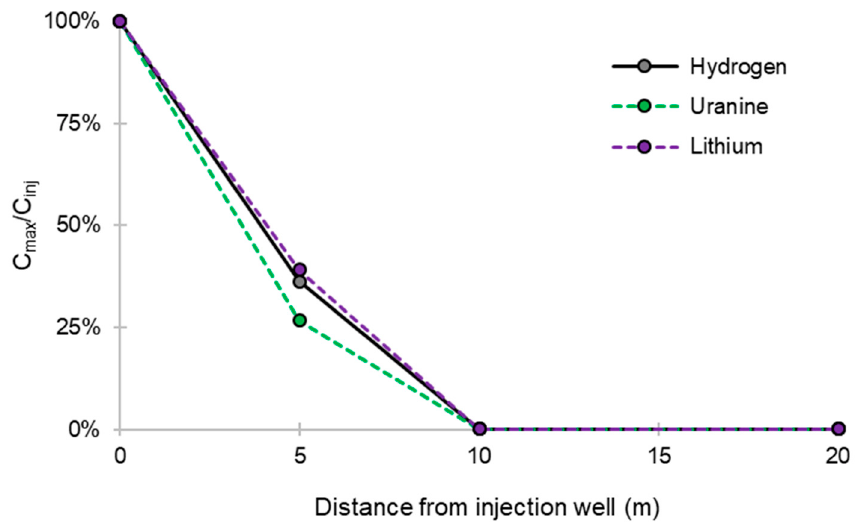
Figure 28. Comparative evolution of the ratio of maximum concentrations (C max ) to the injection concentration (C inj ) of tracers and hydrogen up to 20 m downstream of the injection well.